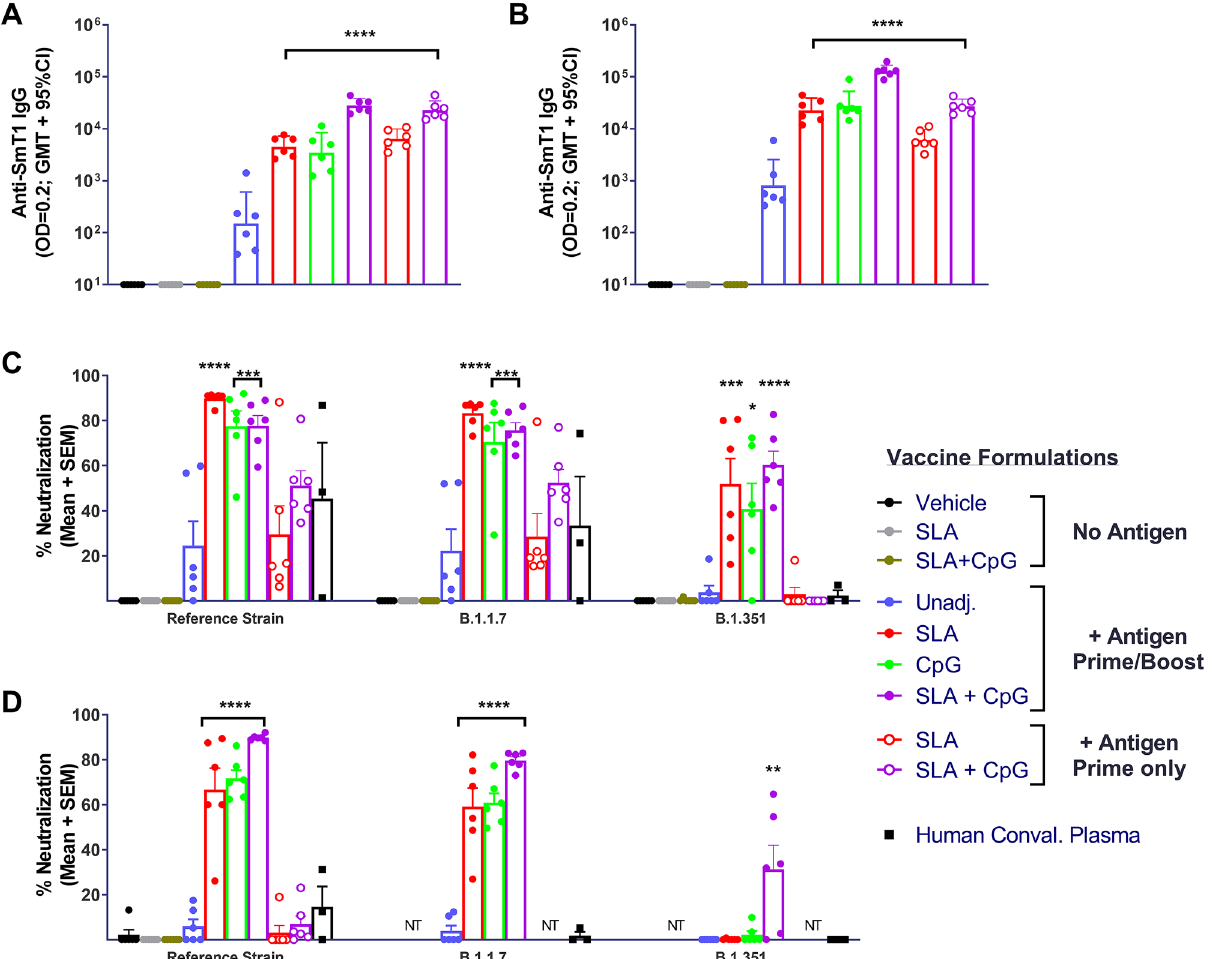
Figure 7. Humoral immune response with SmT1-based vaccine formulations in hamsters. Syrian Golden hamsters (n = 6/group) were immunized i.m. with 3 µg of SmT1 alone or with SLA, CpG or SLA + CpG on Days 0 ± 21. Serum was collected on Days 21 ( A ) and 34 ( B ) and analyzed by ELISA to determine the antibody titers. Grouped data is presented as geometric mean + 95% confidence interval. Serum from Day 34 was also analyzed at a final serum dilution of 1:25 ( C ) and 1:75 ( D ) by cell-based surrogate neutralization assay. Grouped data is presented as mean + standard error of mean. Statistical significance of differences for the adjuvanted groups vs. the antigen alone control group is shown: **p < 0.01, ***p < 0.001 and ****p < 0.0001 by one-way ANOVA followed by Tukey’s multiple comparisons